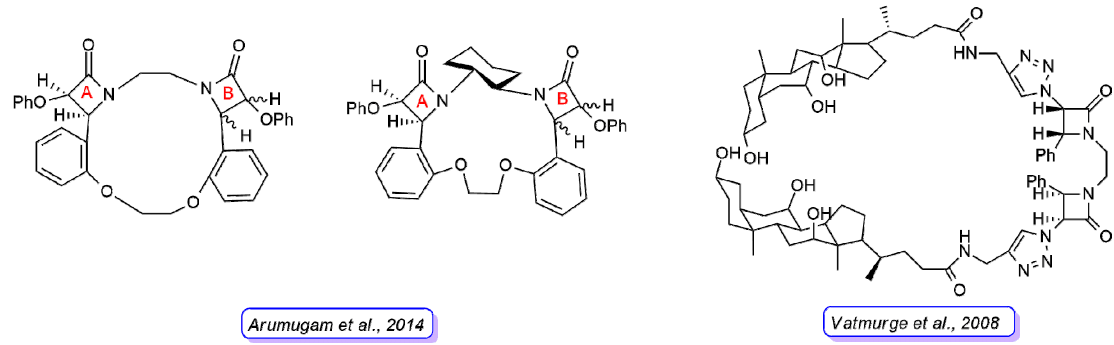
Figure 8. Representative structures of bis- β -lactam macrocycles reported in Refs. [27] (left) and [28] (right). For the compounds synthesized by Arumugam et al., the stereochemistry of the 2-azetidinone ring A is defined in all derivatives, whereas they differ in the stereochemistry of 2-azetidinone ring B .